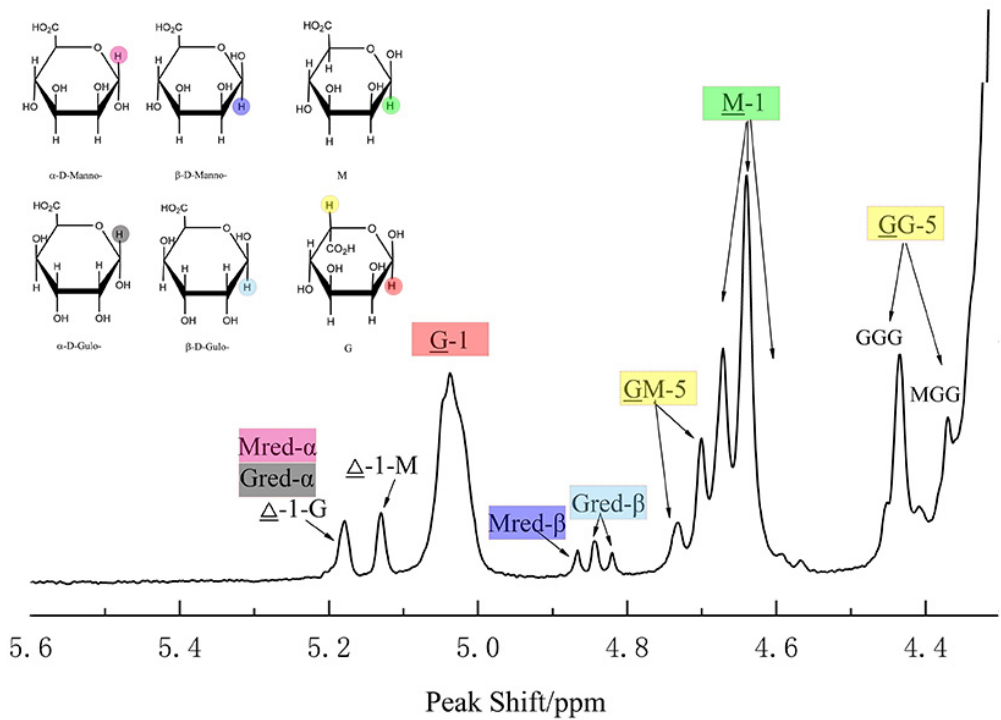
Figure 2. Analysis of alginate by 1 H NMR. The structure of M/G residues and alternative preferred conformations of the anomeric mannosid- and gulosid-uronic acids are named as α -D-Manno -, β - D-Manno-, α -D-Gulo- and β -D-Gulo- in the 1 H NMR spectrum; The inner residues are named as M and G. Assignments of the H1 and H5 signals are shown in same color with the relative